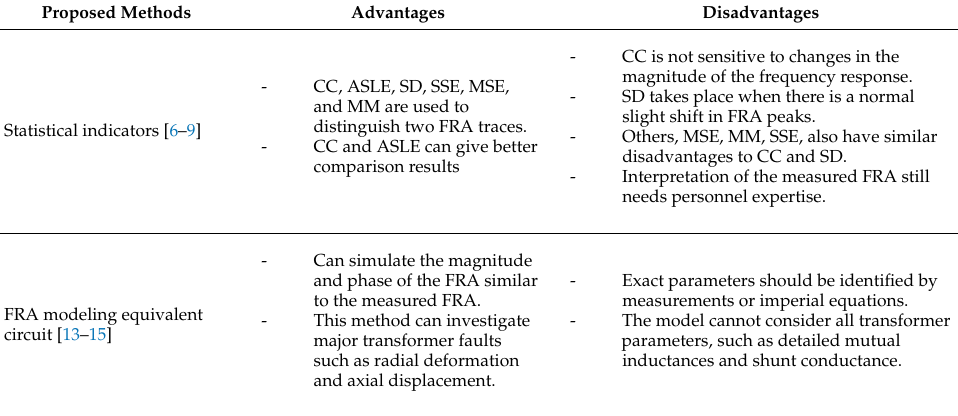
Table 1. Characteristics of various frequency response analysis (FRA) interpretation